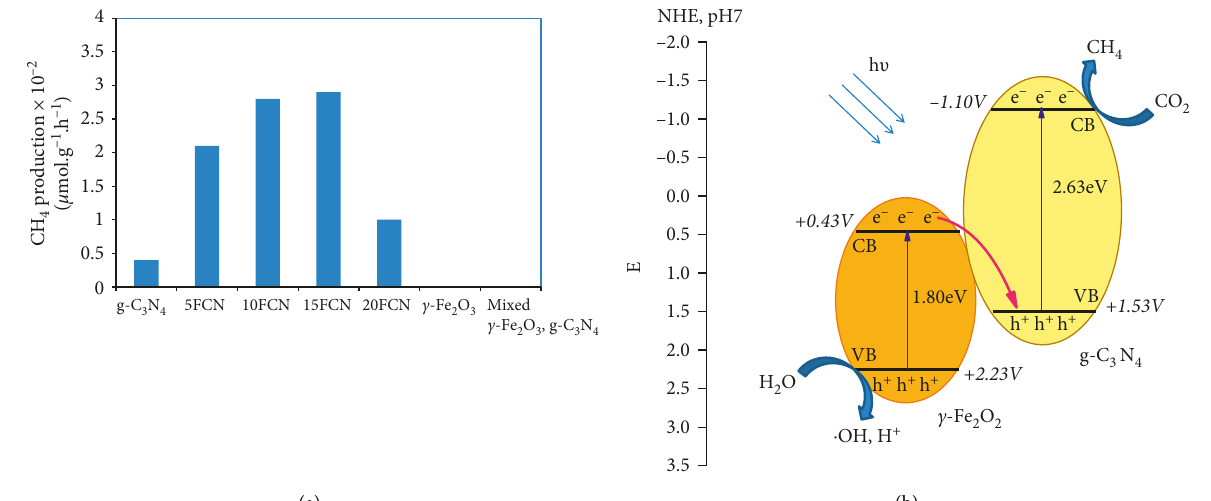
Figure 7: CH 4 production on g-C 3 N 4 and different xFeCN composites (a); proposed mechanism of CO 2 photoreduction on Z-scheme structure of c -Fe 2 O 3 /g-C 3 N 4 (b).